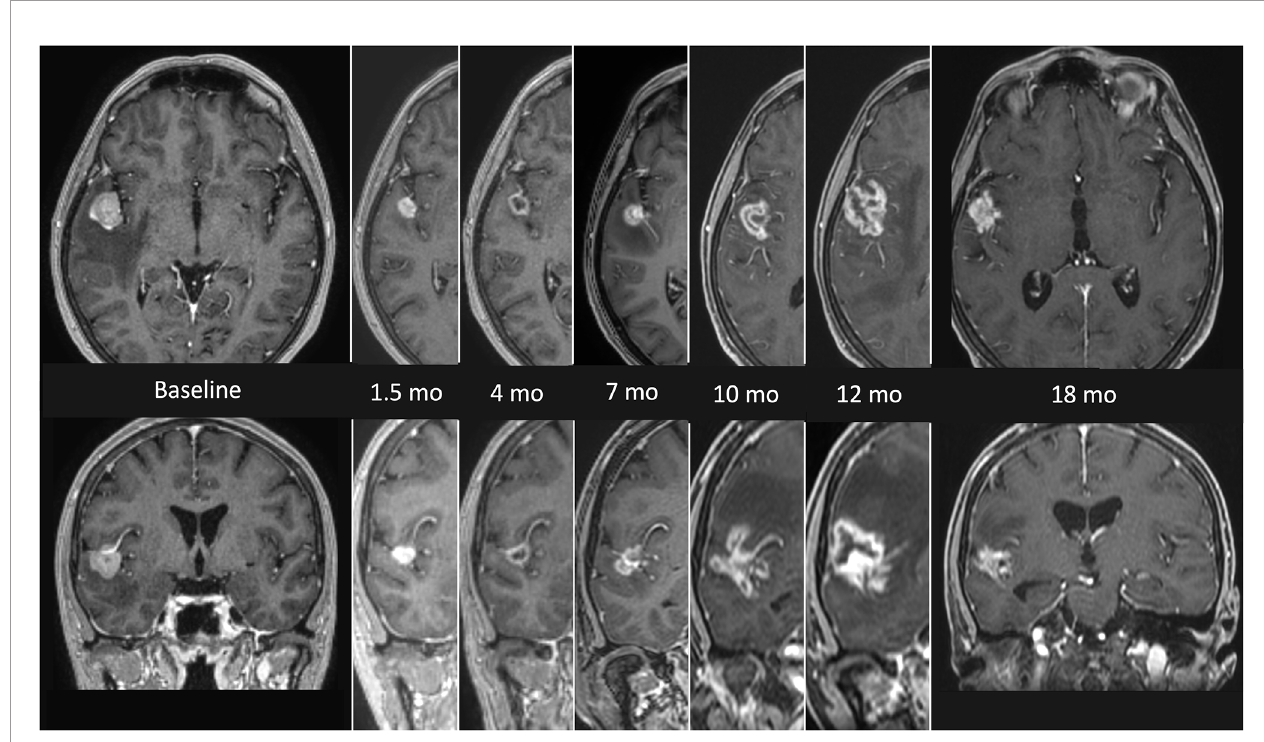
FIGURE 1 | MRI fi ndings presenting the evolution of radionecrosis (RN) within a timeframe of 18 months from the end of radiosurgery (SRS) in a single right temporal BM from NSCLC. The fi rst images on the left (axial and coronal) represent the lesion before focal treatment. Serial follow up images show an initial shrinkage of the treated lesion followed by a signi fi cant and continuous increase of the necrotic component. The latest images on the right (axial and coronal) refers to the situation 18 months after SRS, with a clear reduction of the necrotic component, which allows a differential diagnosis with a